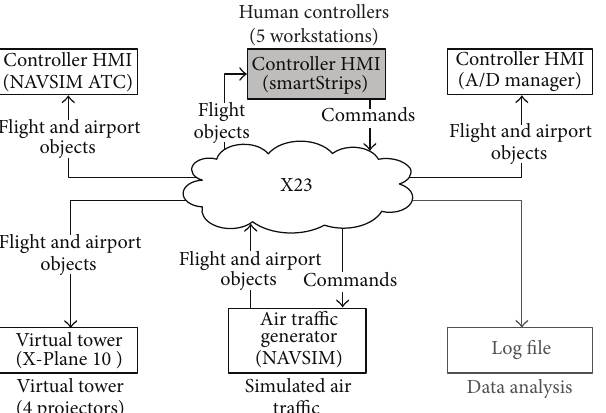
Figure 7: Logical information flow in the simulation’s X23 SWIM network for the EDDH scenario. Flight and airport objects are distributed in the subscribe/notify message pattern. Commands follow the request/response message pattern. The shaded HMI was later replaced with a simulated